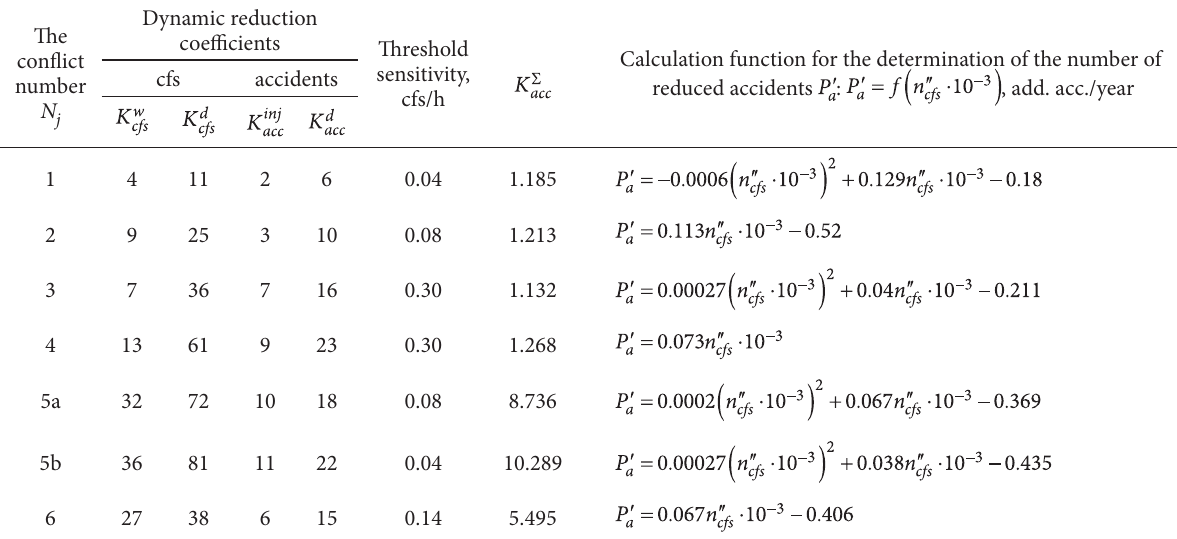
Table 5. Results of experimental researches of conflict situations The conflict number N j